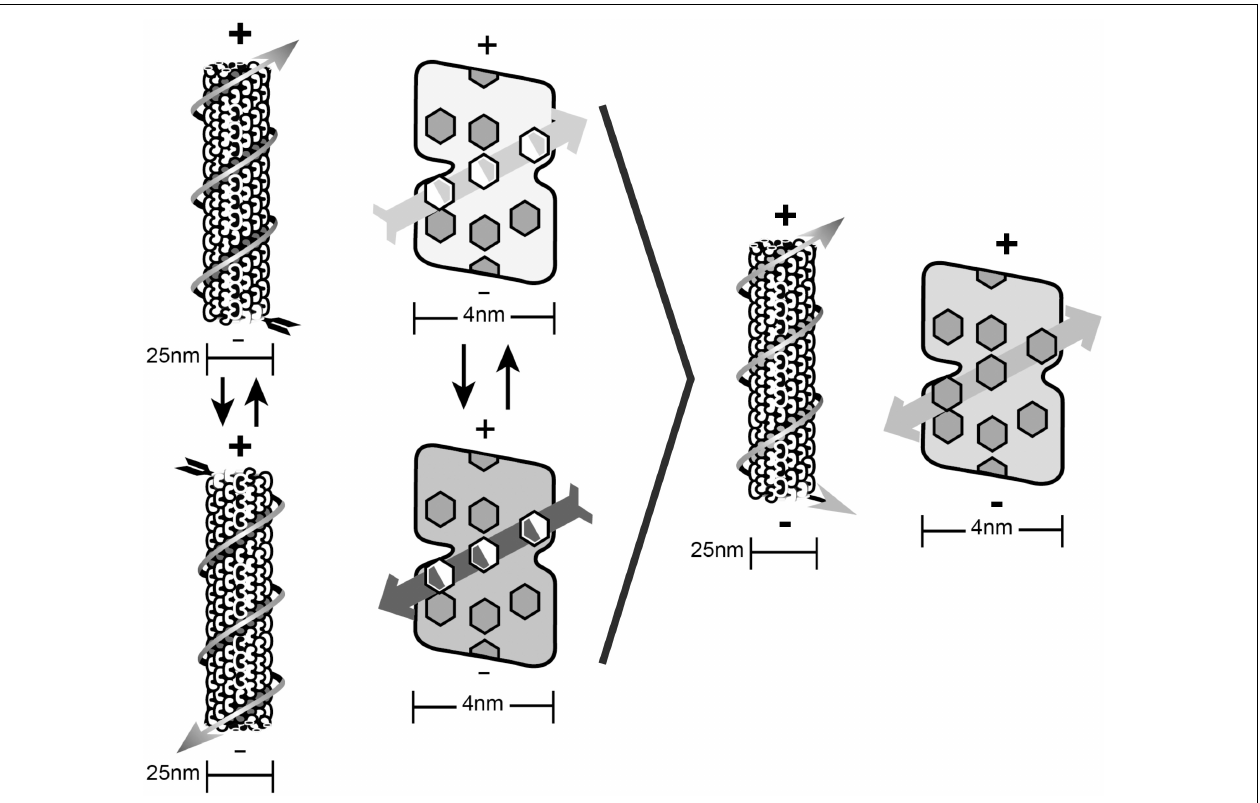
FIGURE 7 | The Orch OR qubit. Helical quantum dipoles in microtubules form coherent states of one orientation or another by Fröhlich “giant dipole” oscillations. Right: Superposition of both dipole orientations form the Orch OR qubit. Separate alternate states are shown on left, superposition of both states on right. The helical pathway shown is the “5-start” pathway in the A-lattice microtubules with Fibonacci geometry (3, 5, and 8-start helical pathways).